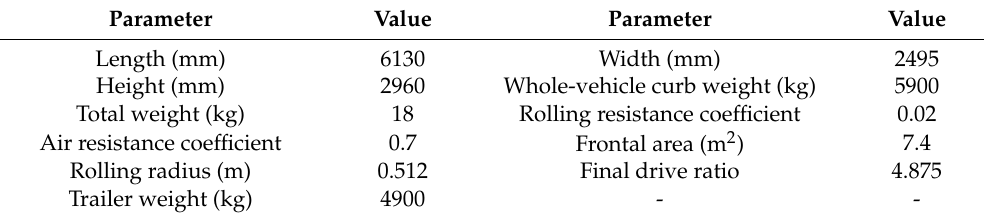
Table 3. Whole-vehicle parameters.